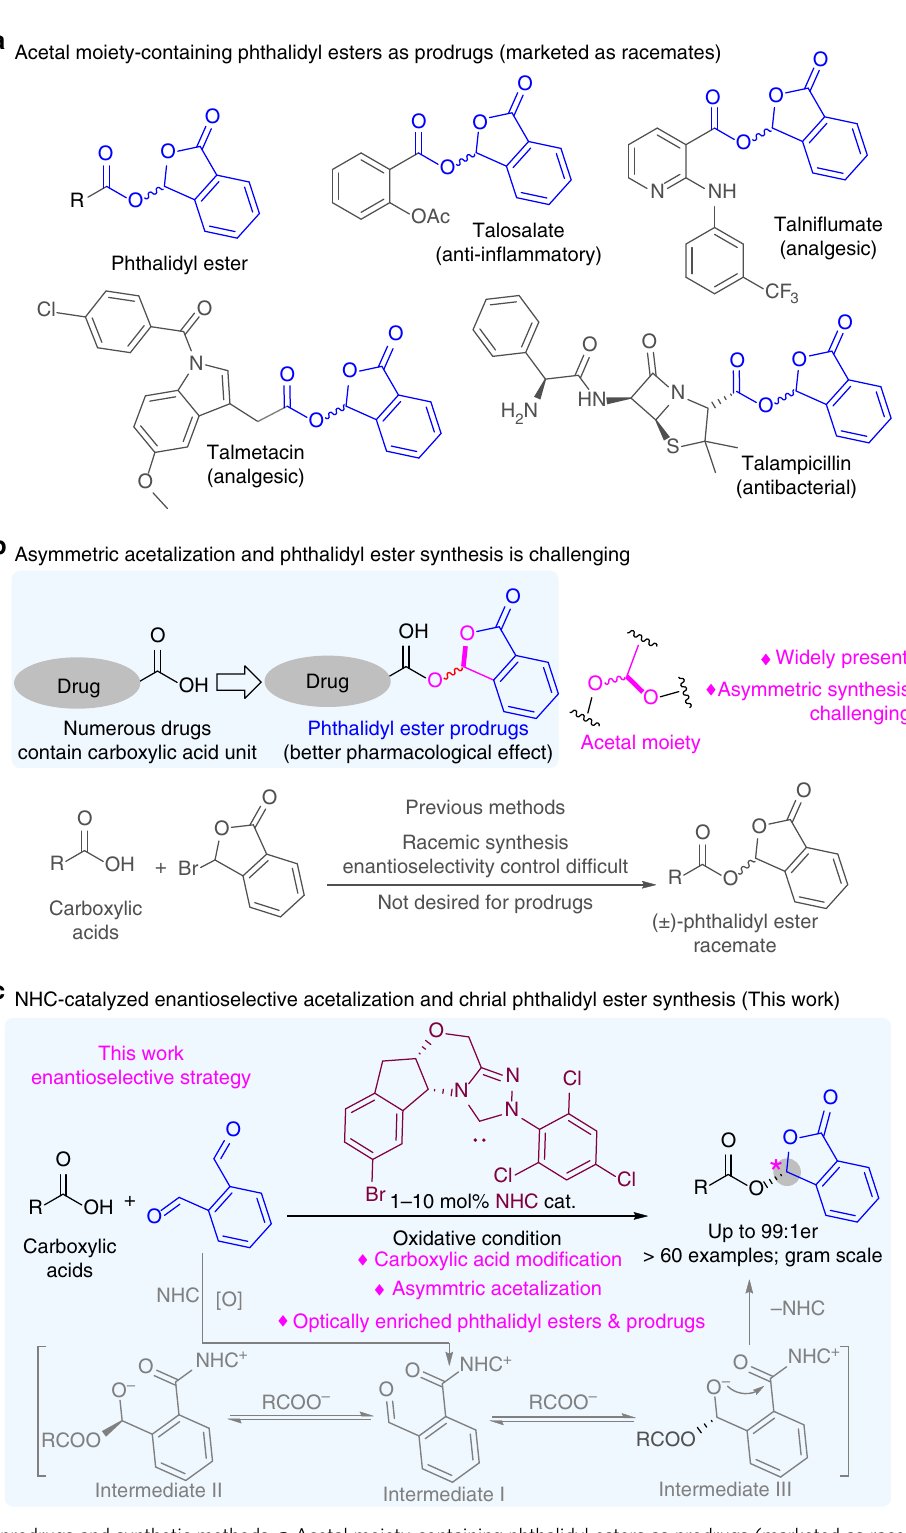
Fig. 1 Phthalidyl ester prodrugs and synthetic methods. a Acetal moiety-containing phthalidyl esters as prodrugs (marketed as racemates) b Asymmetric acetalization and phthalidyl ester synthesis is challenging. c NHC-catalyzed enantioselective acetalization and chrial phtalidyl ester synthesis (this